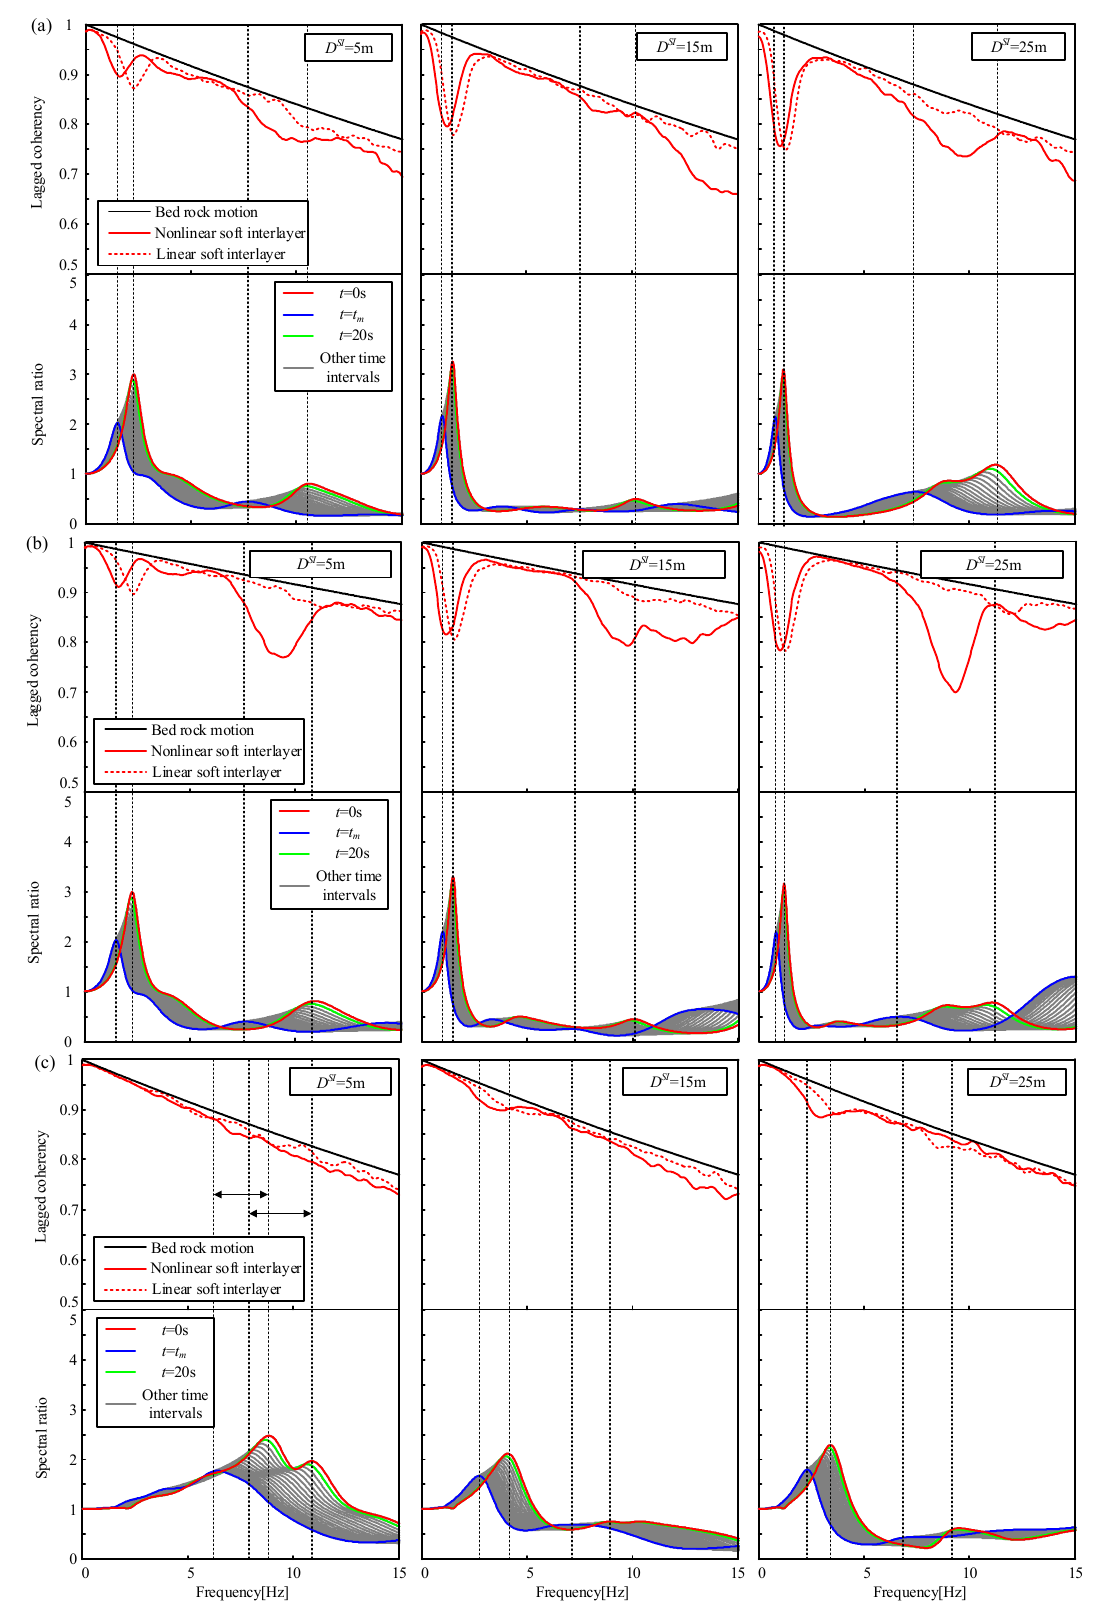
Figure 11. Mean lagged coherency and corresponding time-varying spectral ratios for ( a ) horizontal out-of-plane motions; ( b ) horizontal in-plane motions; and ( c ) vertical in-plane motions under varying buried depth of soft interlayer.